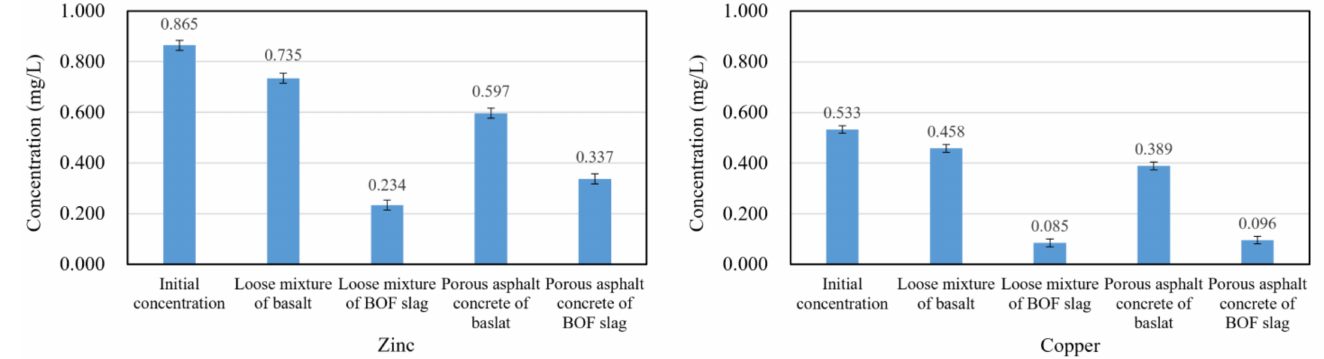
Figure 4. Concentration of zinc and copper in runoff solution at 8